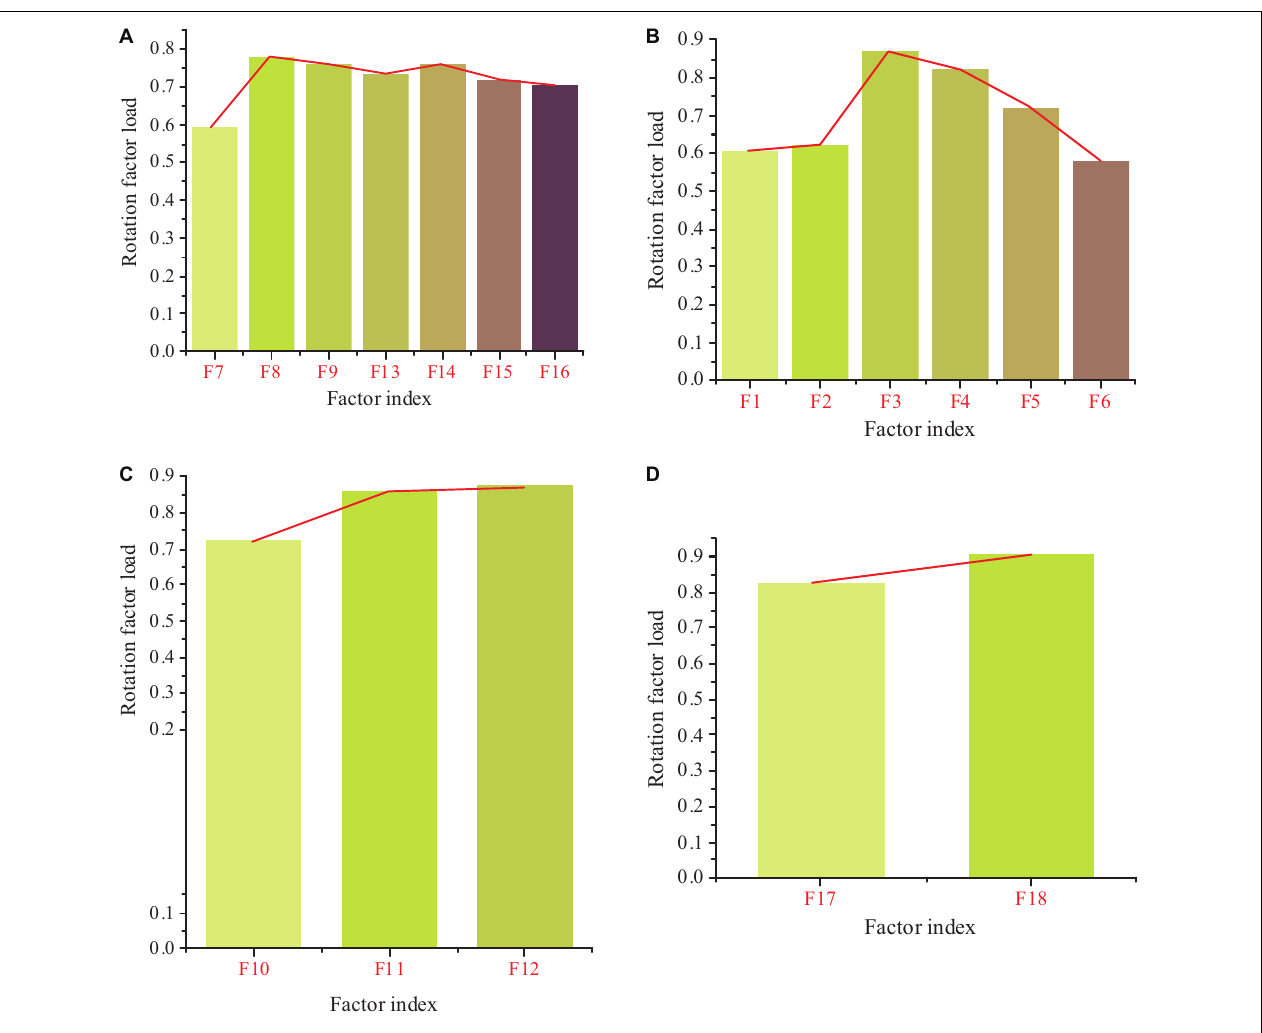
FIGURE 4 | Load value of rotation factor corresponding to 4 key competence indexes. (A) Business execution ability. (B) Team cooperation ability. (C) Strategic thinking ability. (D) Management and decision-making ability.